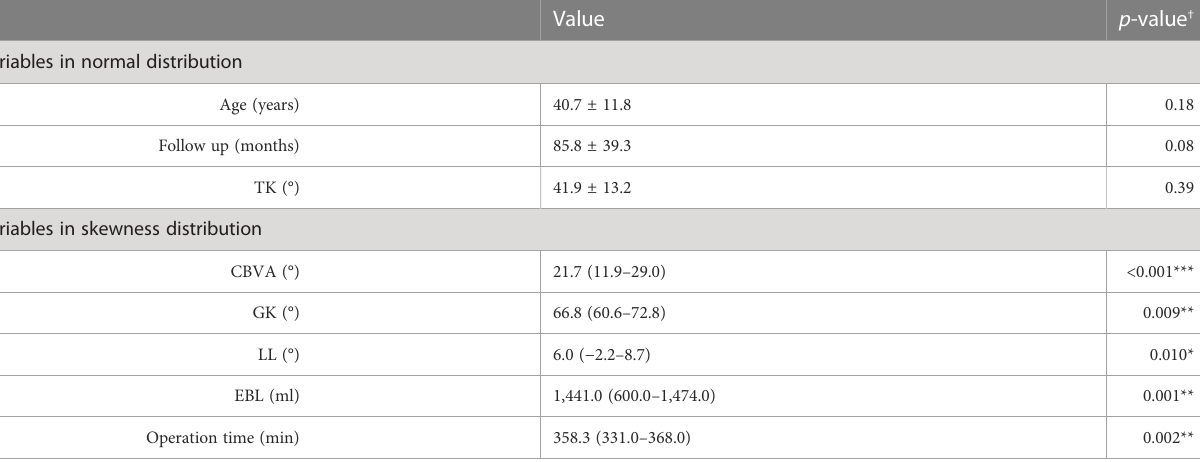
TABLE 3 Normal test of continuous